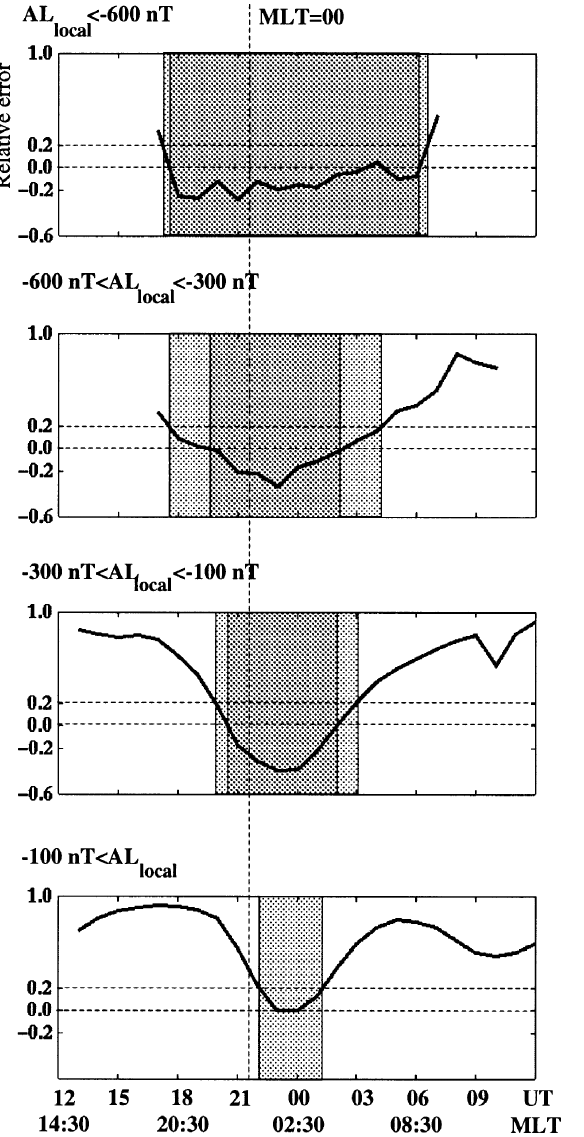
Fig. 5. Activity dependence of the average relative errors between the global and local A ‚ . The data have been binned according to local activity. The UT-periods when the error is below 0.2 and below 0 (i.e. the local chain sees stronger activity than the global one) are marked with lighter and darker shadings , respectively